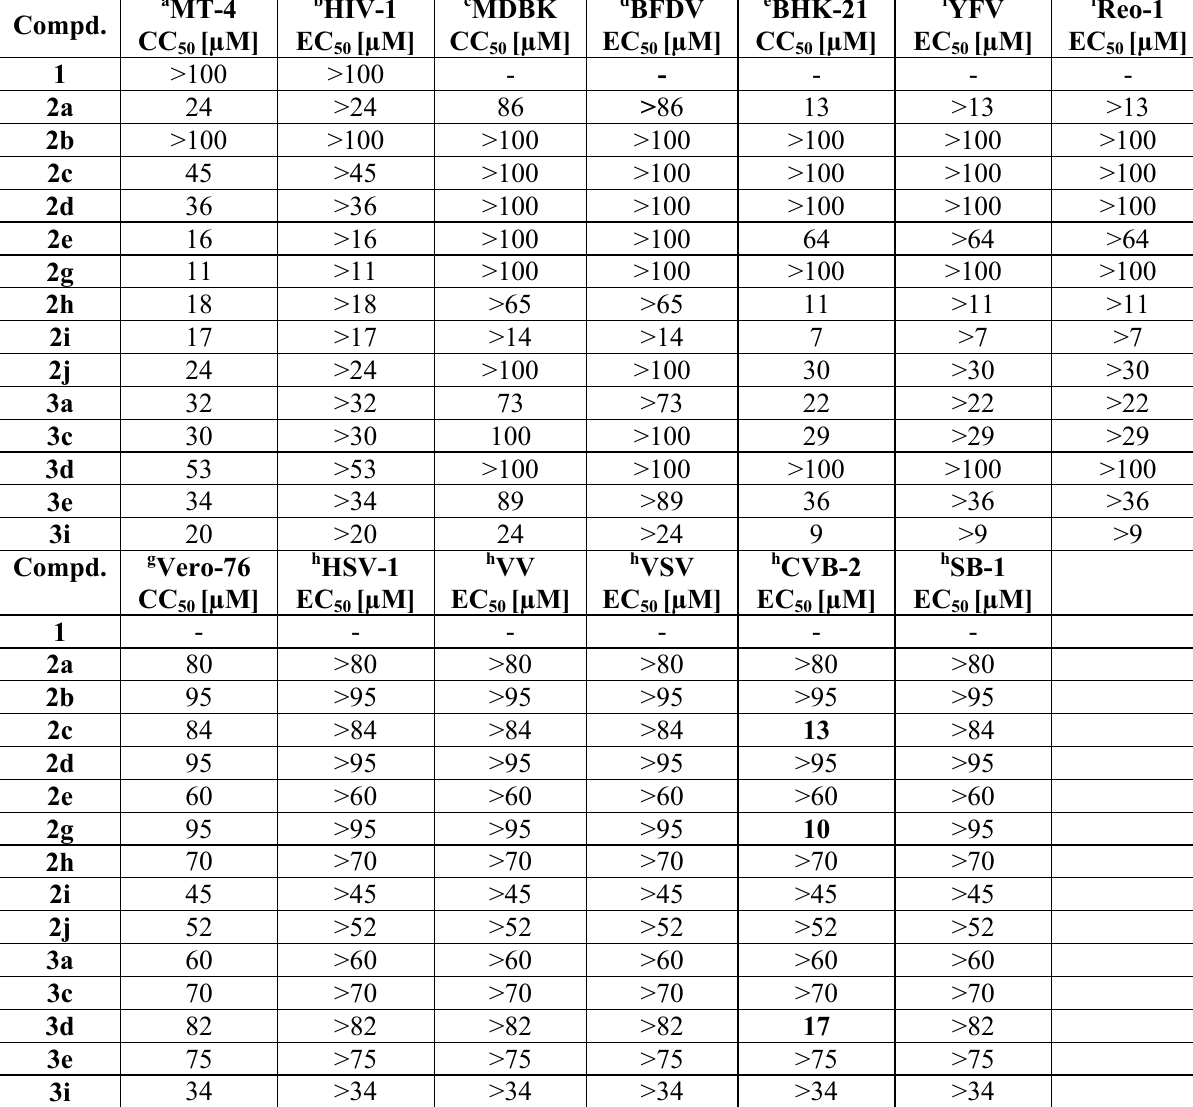
Table 3. Cytotoxicity and antiviral activity of 4-substituted a arylpiperazine derivatives of 1,7,8,9-tetrachloro-10,10-dimethoxy-4-azatricyclo[5.2.1.0 2,6